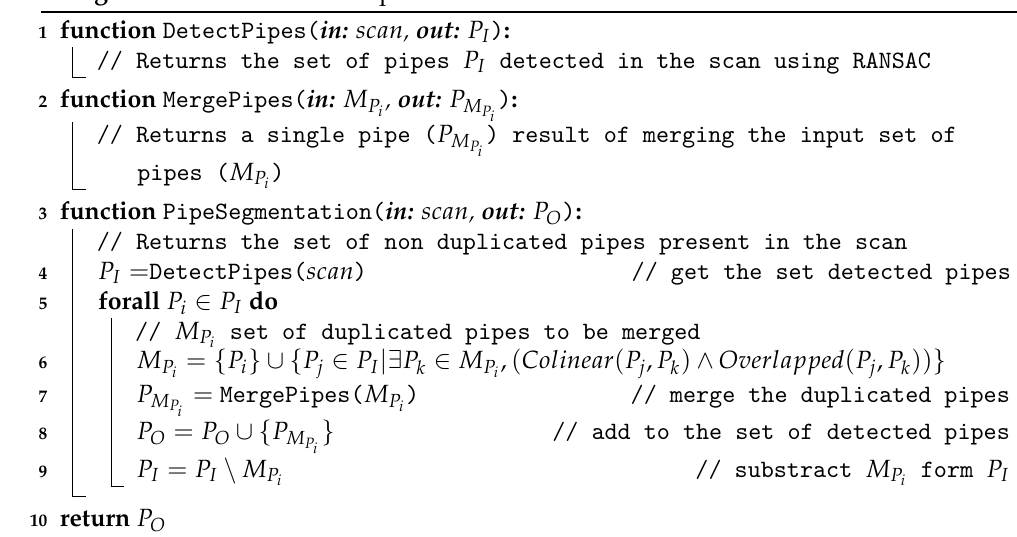
Algorithm 1: Detection of Pipes and